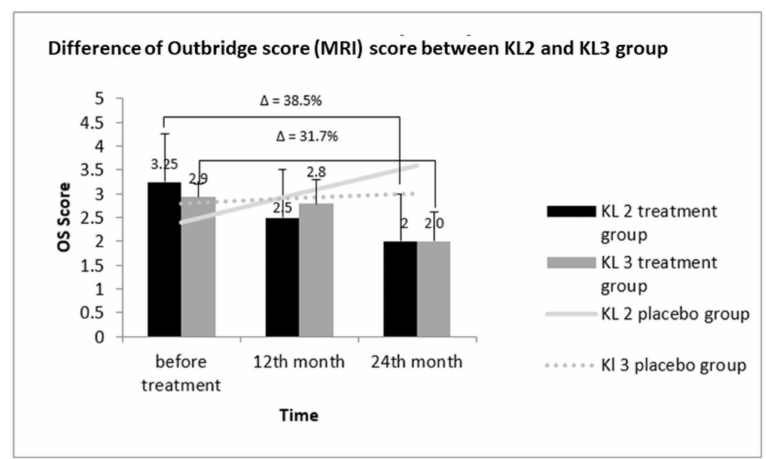
Figure 7. OS in SVF-treated and placebo groups of KL-grade 2 and 3 patients after at 12 and 24 months. After treatment, improvement was noted in KL-grade 2 and KL-grade 3 patients (38.5% and 31.7%). ∆ : percentage of reduction in OS